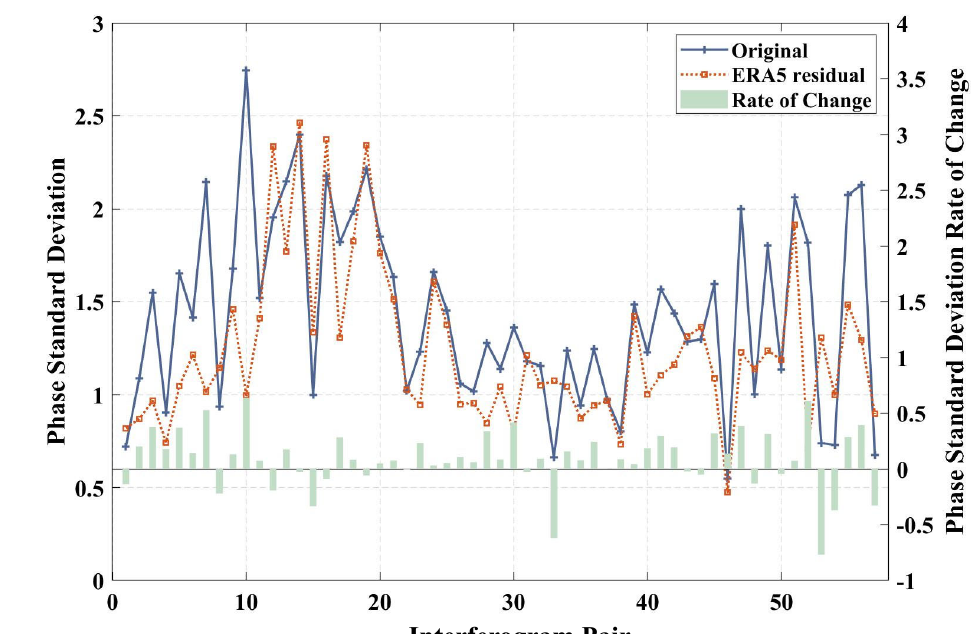
Figure 5. Phase standard deviation of original interferogram and ERA5 residual interferogram. The light green bar represents the Original − Residual/Original rate of phase standard deviation change. The positive value represents the decrease in standard